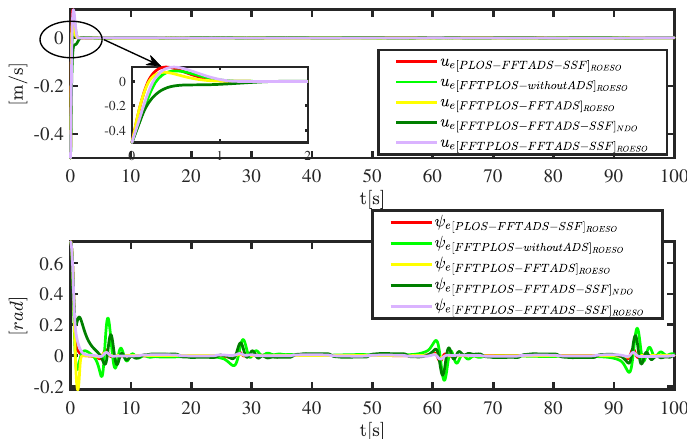
Figure 5. The tracking errors of the surge velocity and heading angle.